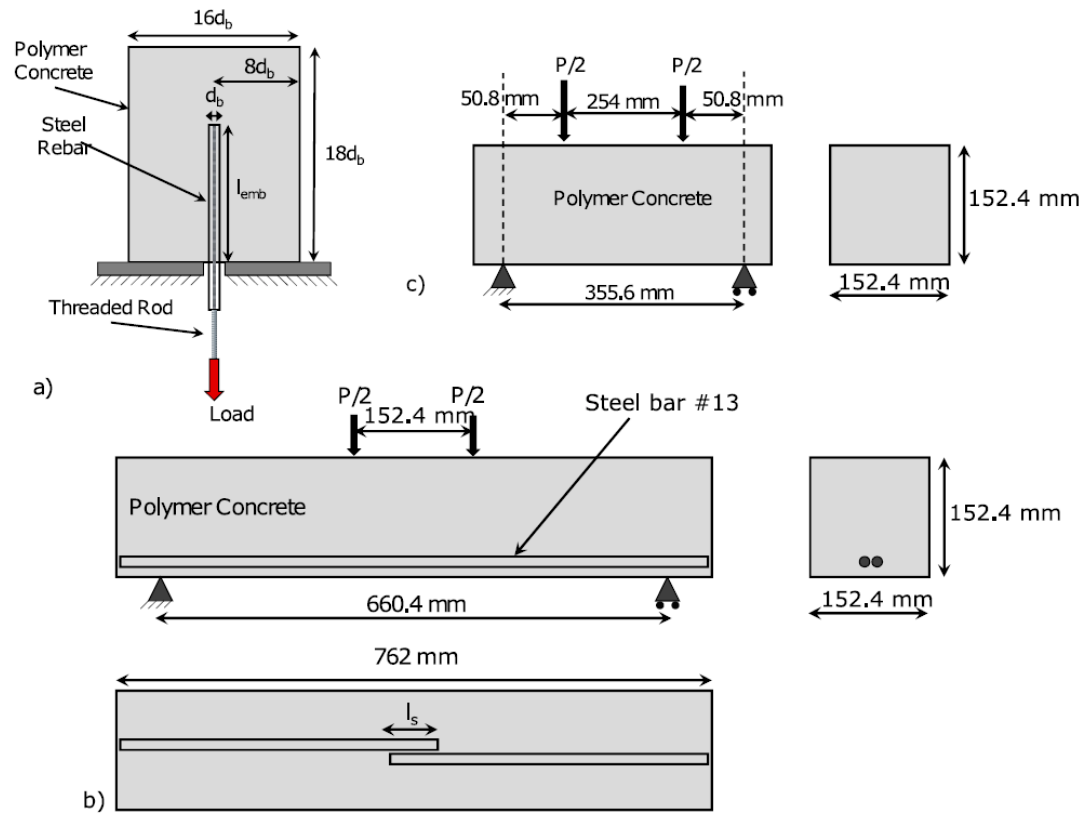
Figure 3. Test setups: ( a ) pull-out test setup; ( b ) lap splice test setup; ( c ) shear strength test setup.